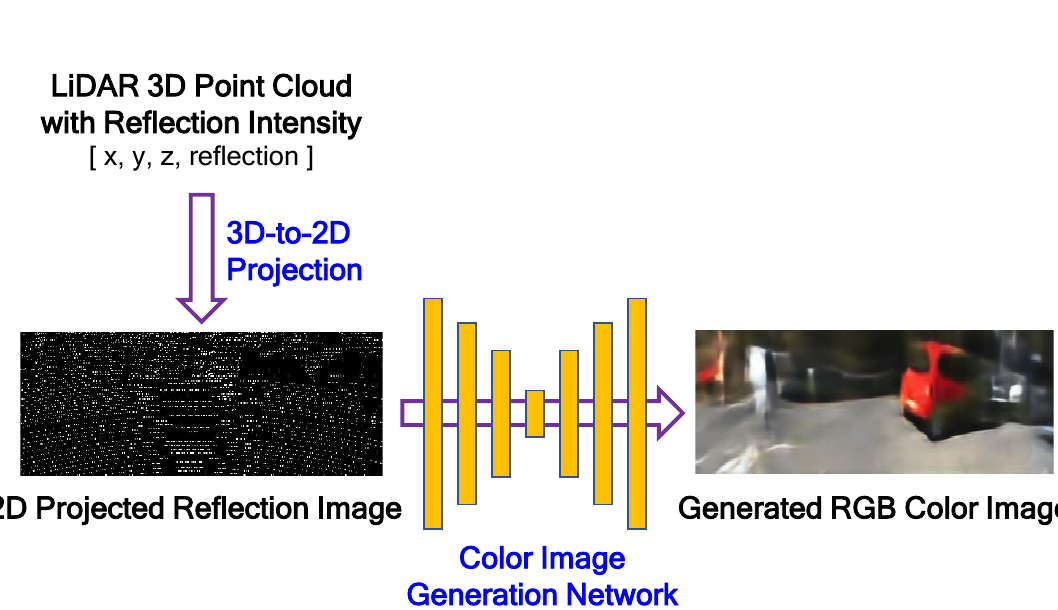
Figure 2. The proposed color image-generation system